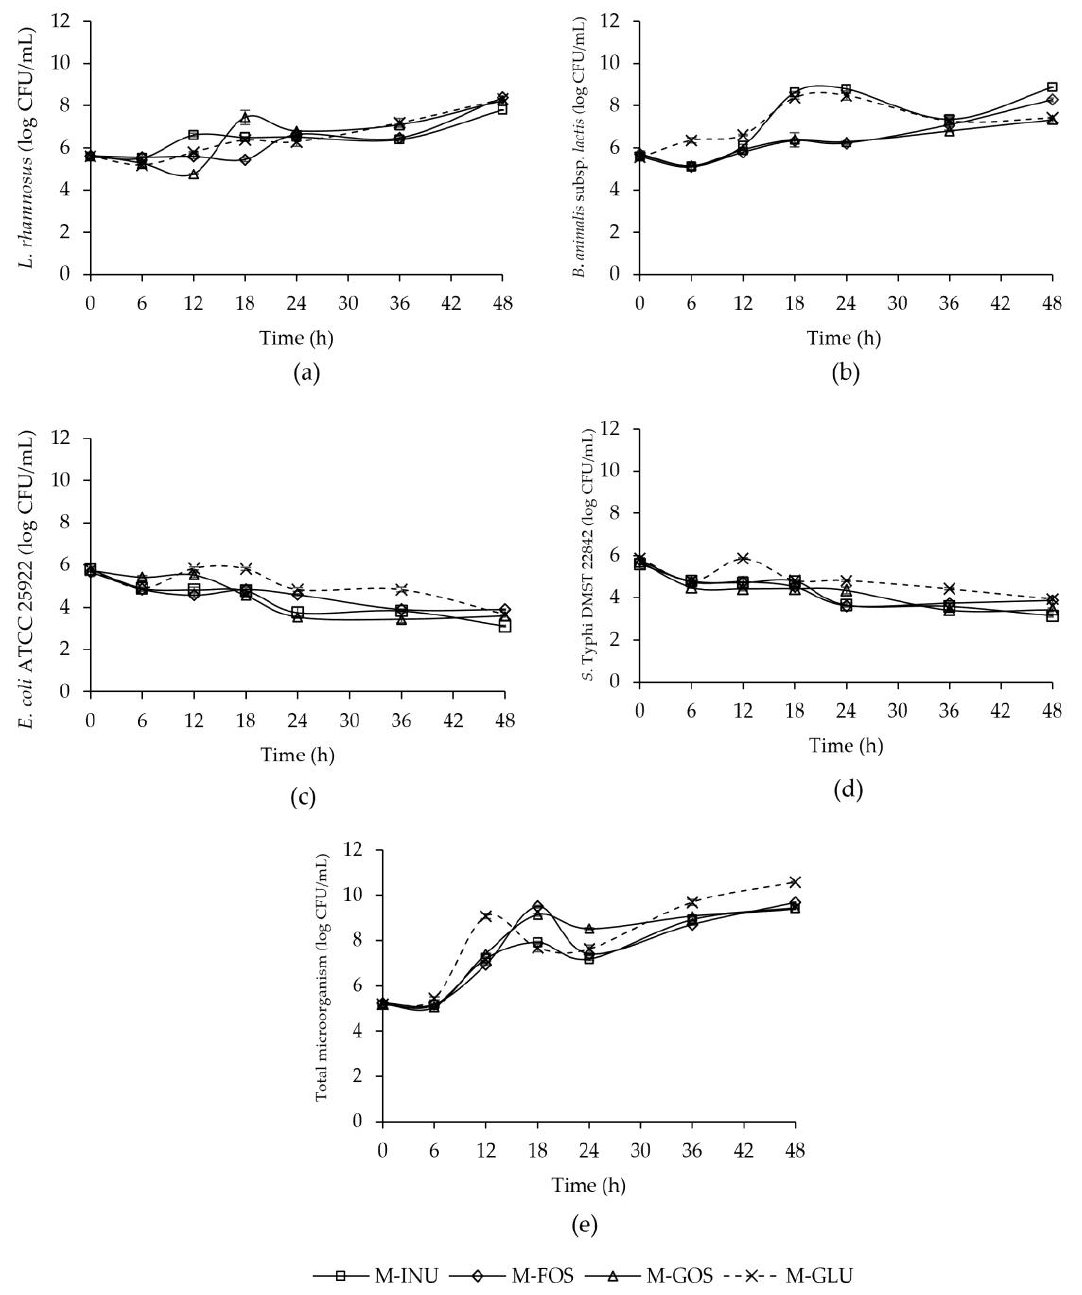
Figure 3. The growth kinetics of ( a ) L. rhamnosus , ( b ) B. animalis subsp. lactis , ( c ) E. coli ATCC 25922, ( d ) S. Typhi DMST 22842, and ( e ) total bacteria for co-culture bacterial strains in the different mediums supplemented with glucose (control) and prebiotics.